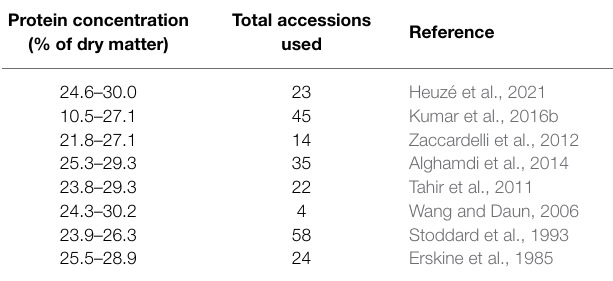
TABLE 1 | Genetic variation for protein concentration in cultivated lentils ( L. culinaris ). Protein concentration (% of dry matter)